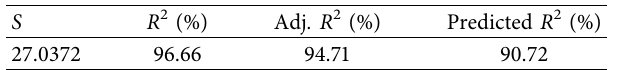
Figure 4: Interaction plot for response. Table 2: Model summary.